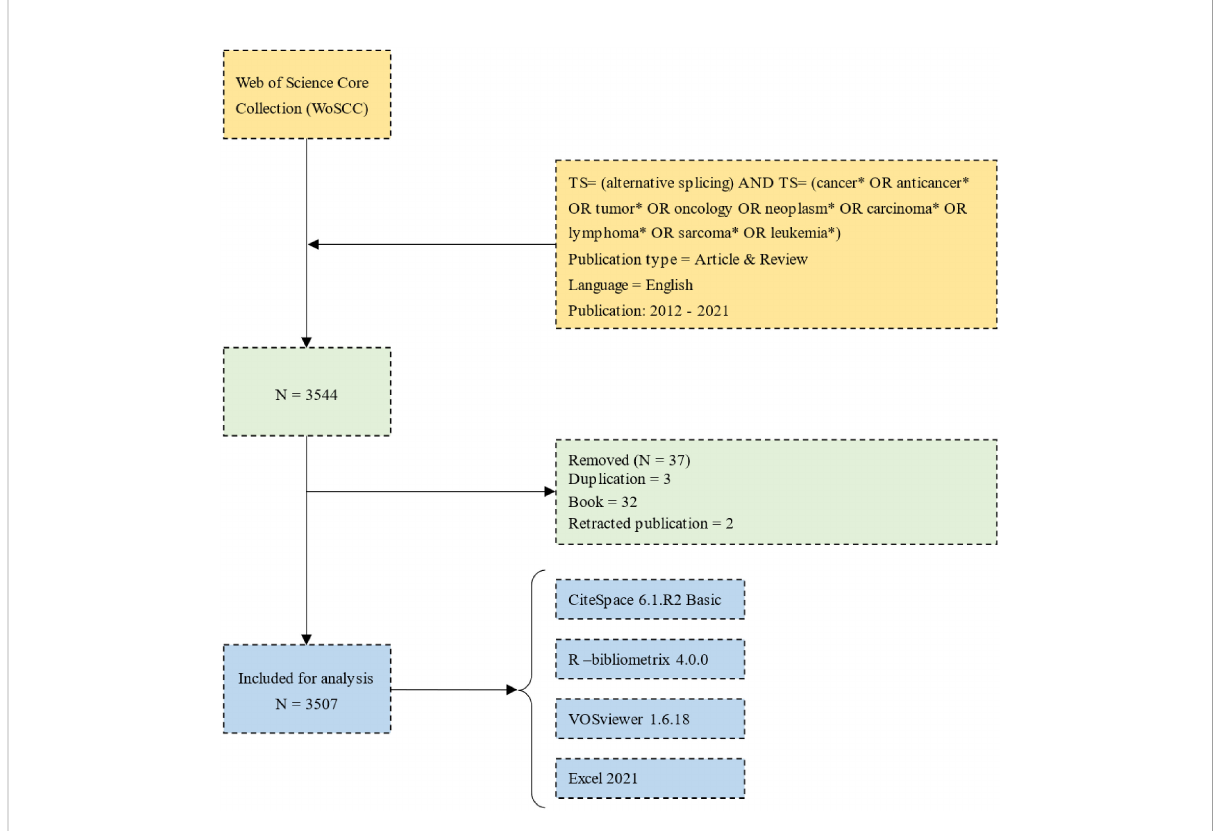
FIGURE 1 Flowchart of data collection, cleaning, and